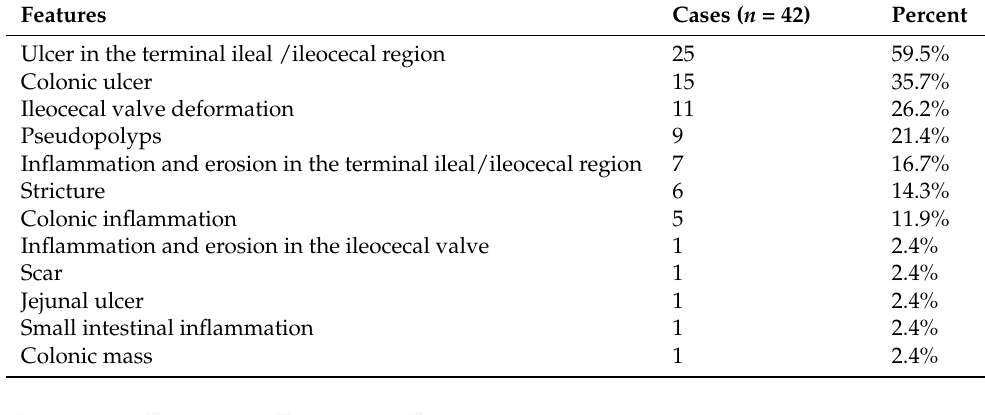
Table 6. Endoscopic features of patients with intestinal tuberculosis.